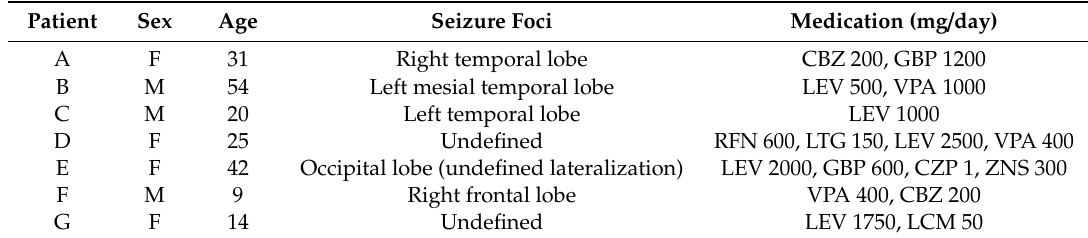
Table 1. Patient demographic and clinical characteristics. Medications were carbamazepine